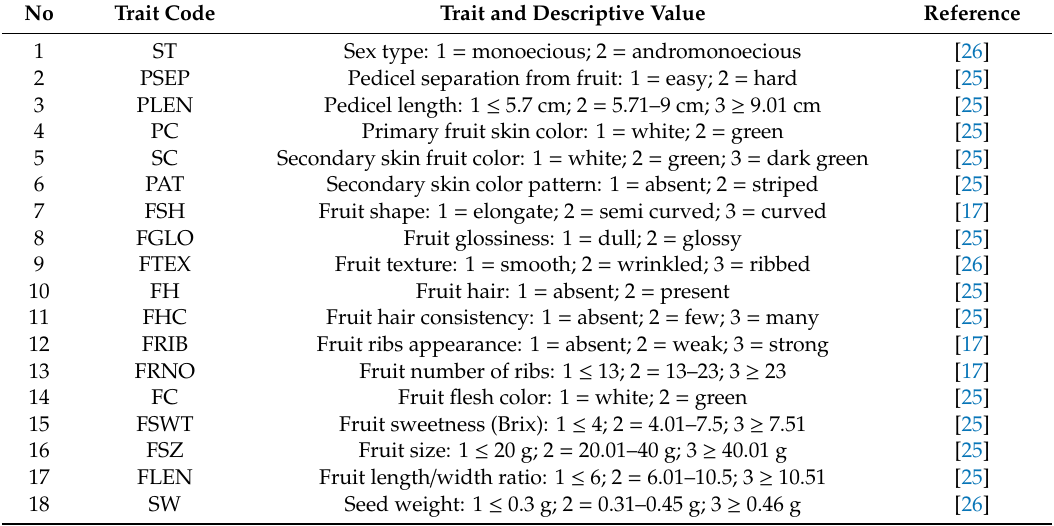
Table 2. Morphological traits recorded in the Lebanese snake melon